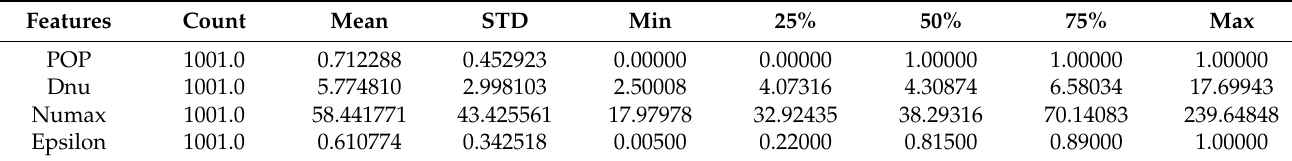
Table 4. The statistical data analysis of asteroseismology features